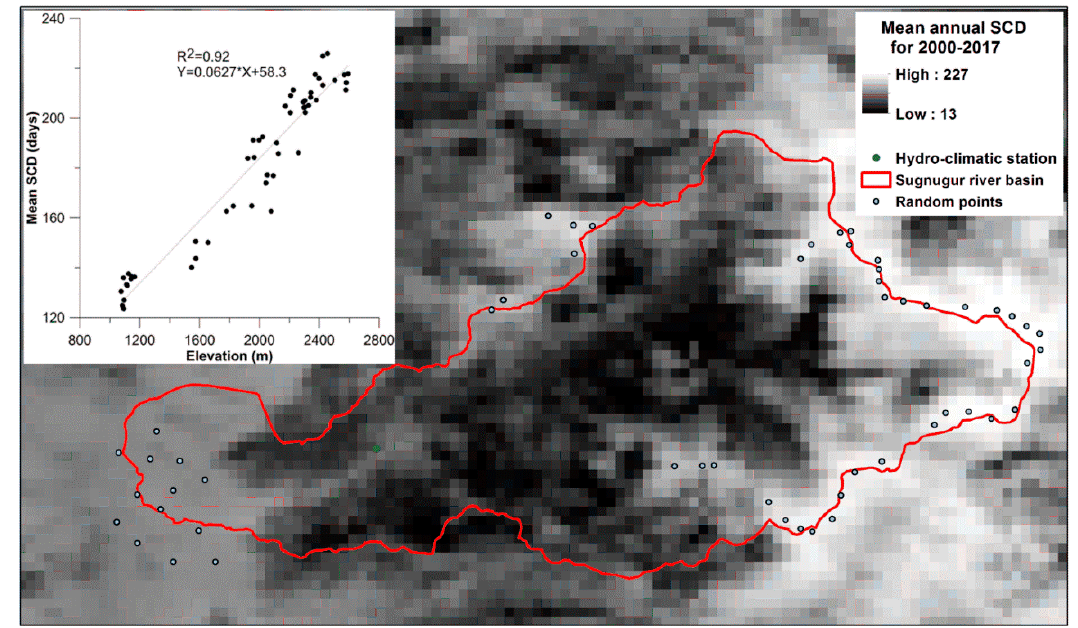
Figure 6. Mean annual snow cover duration (SCD) for 2000–2017 from the improved MODIS-Terra and the derived mean SCD rate (inset image). Green and blue dots denote the locations of hydro-climatic station and selected random points, respectively. Areas with heterogeneous topography and forest cover mostly in the middle part of the catchment demonstrate significant underestimation, such as only 13 days, as shown in the scale.